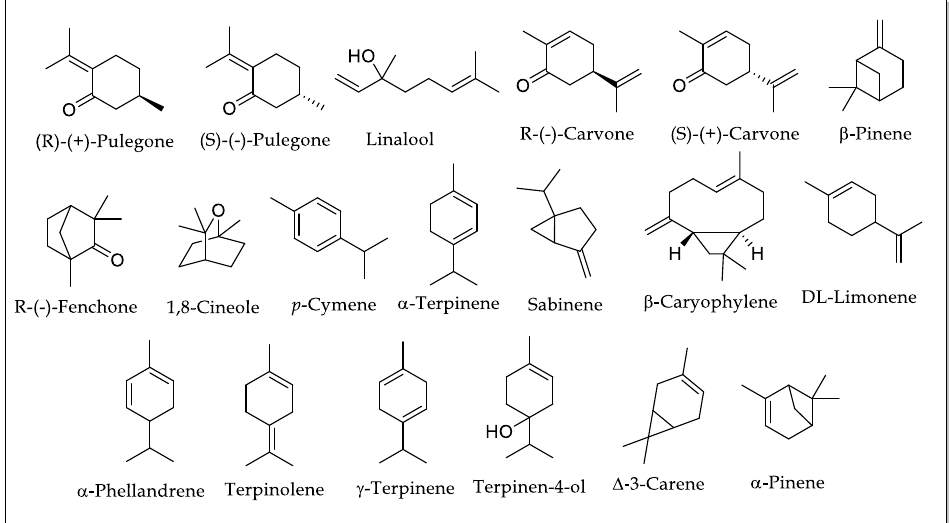
Figure 9. Chemical structures of the 19 ICs evaluated in the fumigant test.